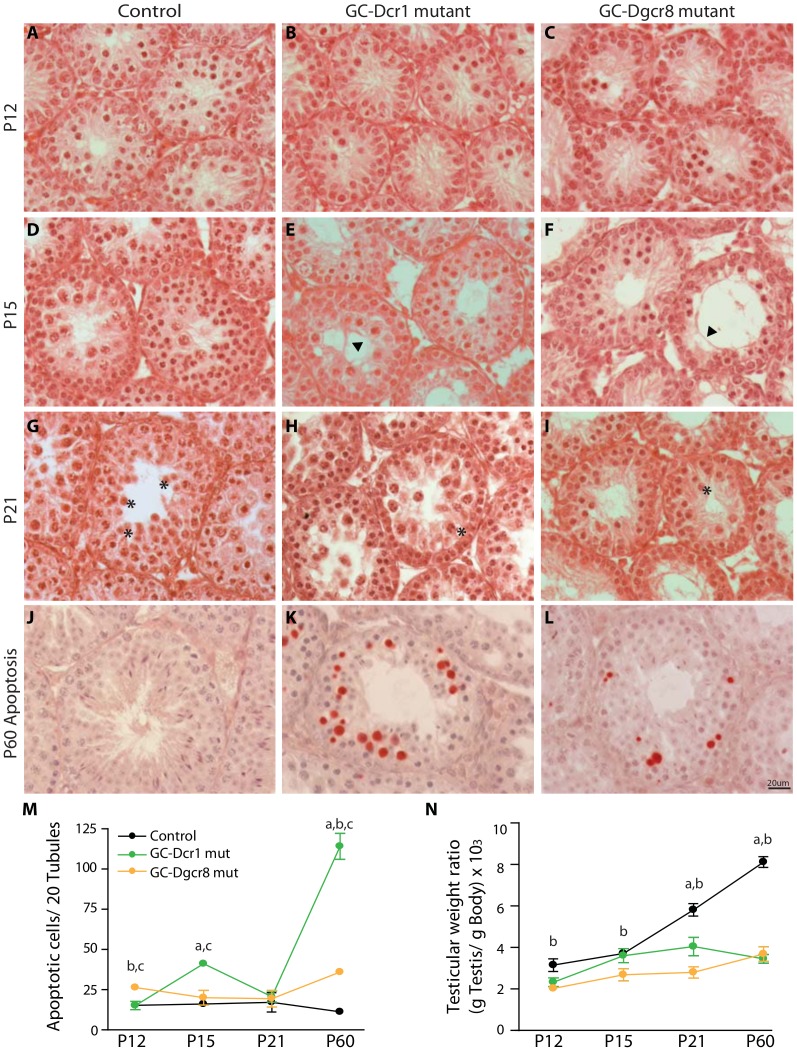
Tubular defects in GC-Dcr1 and GC-Dgcr8 mutant testes appear from P15.H&E staining of control (A,D,G), GC-Dcr1 mutant (B,E,H) and GC-Dgcr8 mutant (C,F,J) testes at P12 (A–C), P15 (D–F) and P21 (G–J). The anatomical defects include germ cells sloughing, Sertoli cell cytoplasmic extensions (arrowheads), reduction in the number of round spermatids (asterisks), and apoptosis and disorganization of the seminiferous epithelium. The increase of apoptotic rate (M) correlates with the reduced testis weight ratio (N) during the first wave of spermatogenesis. (J–L) Apoptotic cells revealed by TUNEL assay on testis sections at P60. Results are mean ± SEM (n = 3/genotype), a = p<0.05 GC-Dcr1 mut vs. control, b = p<0.05 GC-Dgcr8 mut vs. control and c = p<0.05 GC-Dcr1 mut vs. GC-Dgcr8 mut. Scale bars: 20 µm.